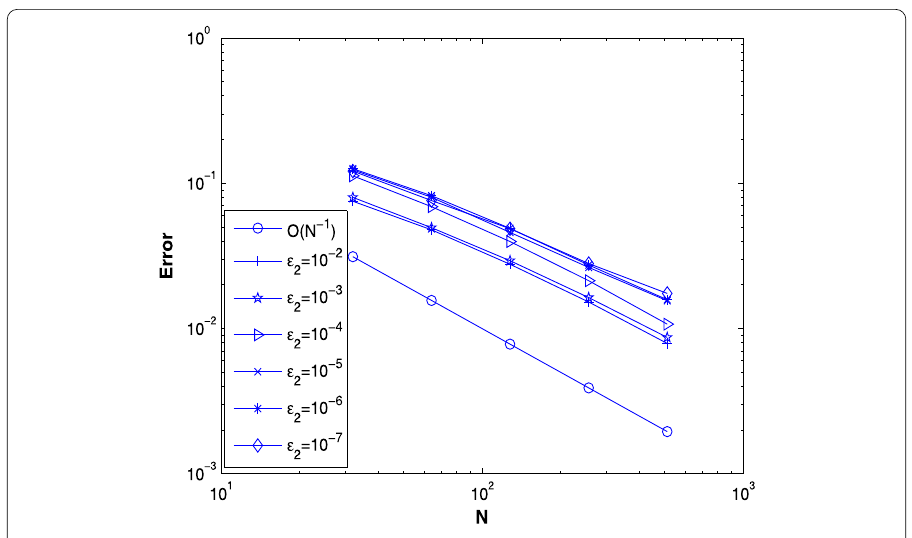
Figure 8 Loglog plot of the maximum error of the solution for Example 5.2 with ε 1 = 10 –2